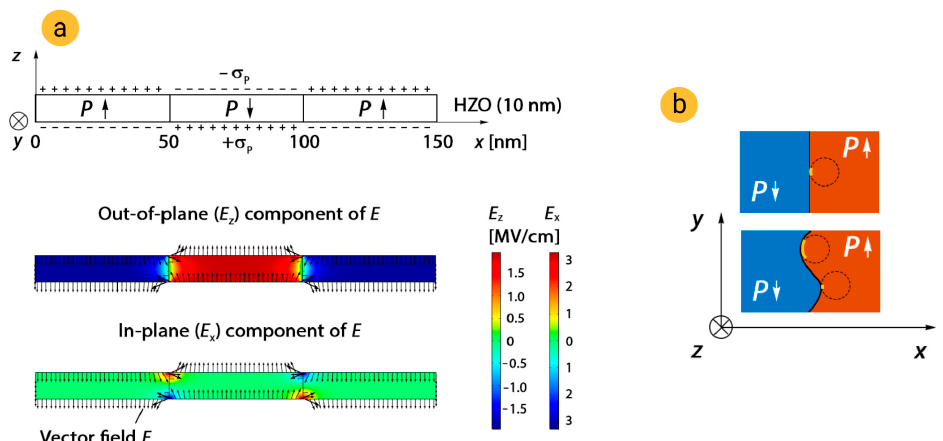
Figure 6. Examination of possible contribution of the electric field of domain walls. ( a ) Model parameters and results of computing of distribution of electric field. ( b ) Illustration of impact of bending and straight domain wall. Circles mark the regions, which will be switched to P ↓ state; yellow lines mark contact segments. Table 1. Switching kinetics parameters for HfO 2 -based capacitors obtained by different